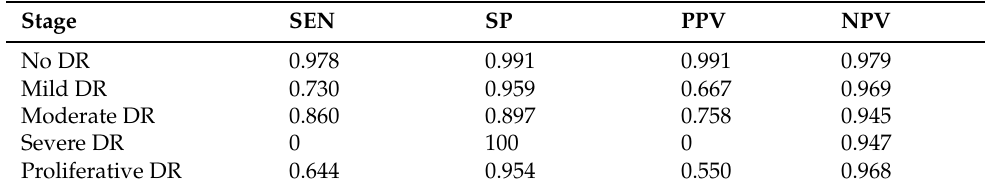
Table 12. The performance measures of the DR stages using CNN512 for the APTOS 2019 dataset.